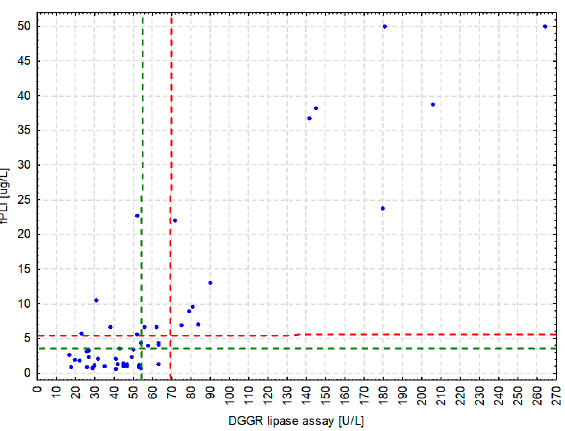
Figure 1. Scatter plot presenting moderate correlation (expressed as the Spearman’s rank correlation coefficient [R s ]) between feline pancreatic lipase immunoreactivity (fPLI) and DGGR-lipase assay. Broken lines indicate cut-off values: green-3.5 μ g/L for fPLI and 55 U/L for the DGGR-lipase assay; red-5.3 μ g/L for fPLI and 70 U/L for the DGGR-lipase assay.